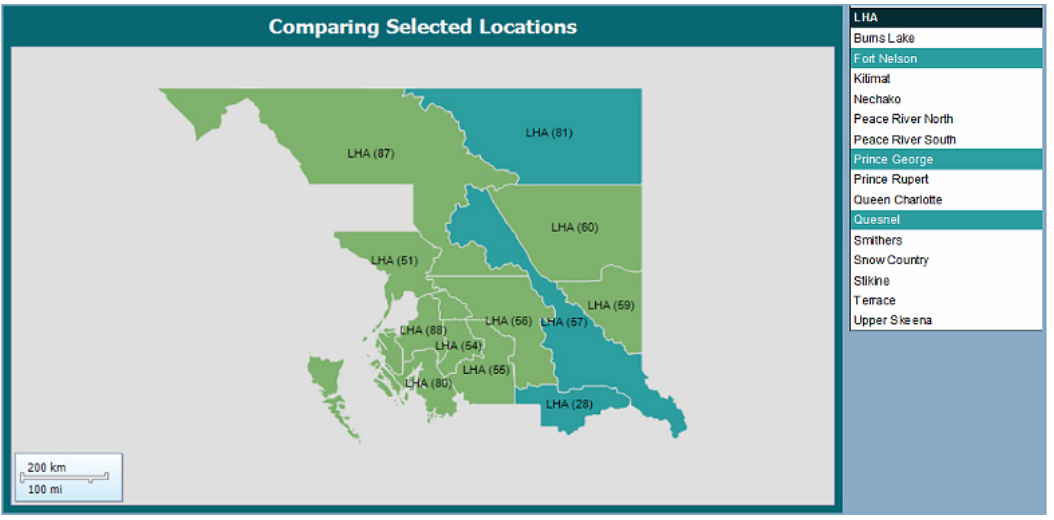
Figure 8. Comparison